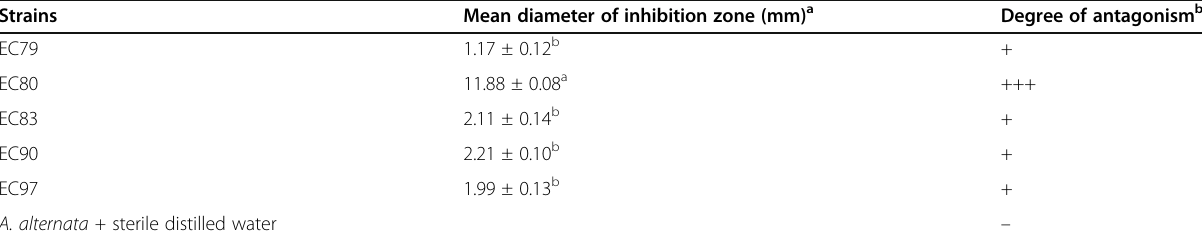
Table 1 In vitro inhibition of growth of Alternaria alternata by single bacterial antagonists on PDA medium Strains